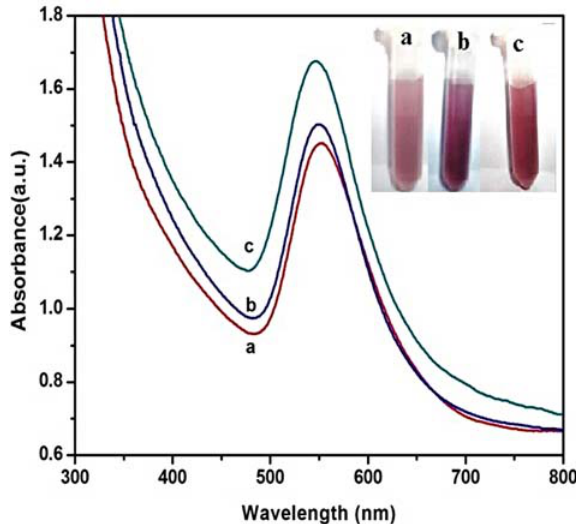
Figure 1. Optical absorption spectra of AuNPs at different concen- tration of A.comosus fruit extract (inset: colour changes of the pre- pared AuNPs) (a, b and c vs 5, 10 and 15 ml